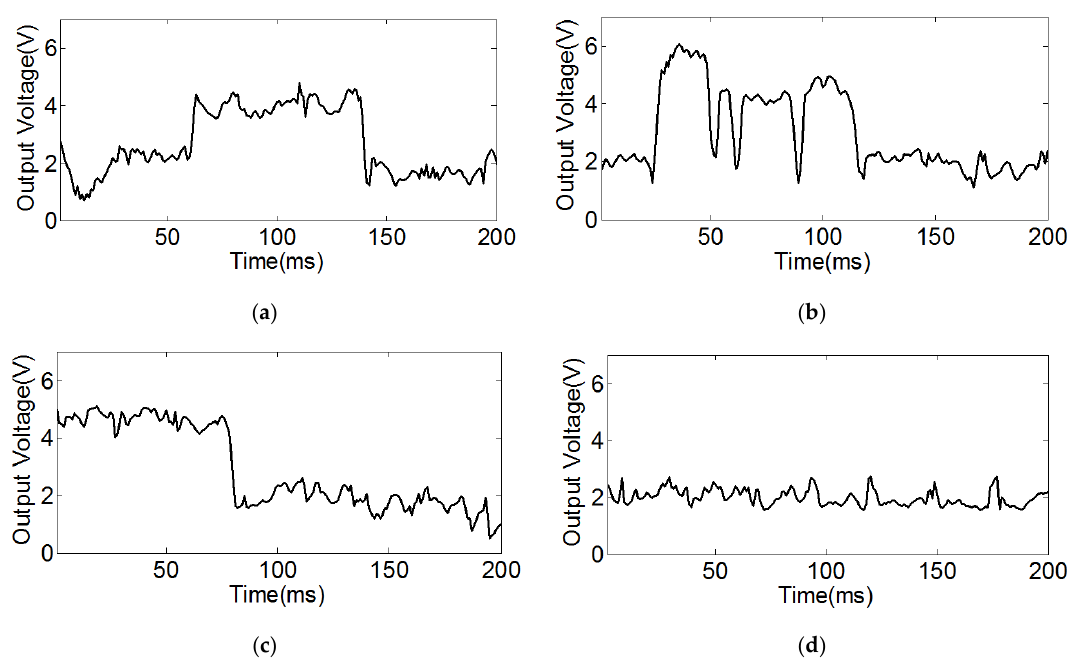
Figure 11. The inspection voltage curve. ( a ) The inspection curve of linear cracks; ( b ) The inspection curve of arc cracks; ( c ) The inspection curve of cross cracks; ( d ) The inspection curve of the steel ball without defect.